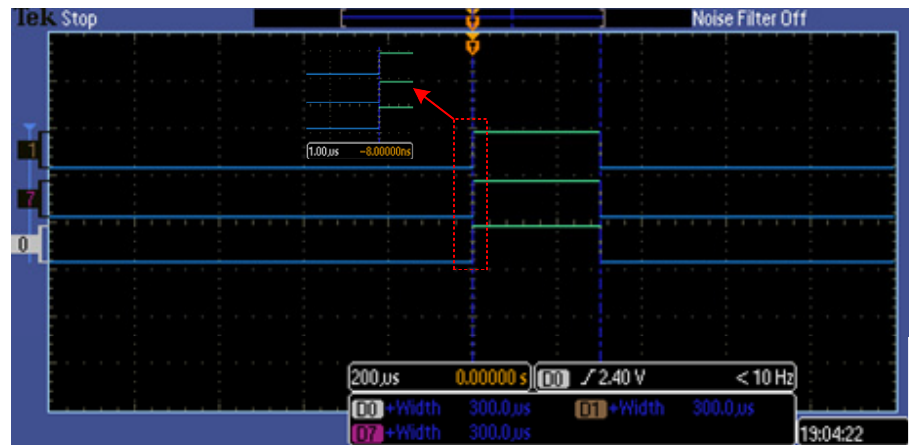
Figure 7. PPS signals read by oscilloscope.